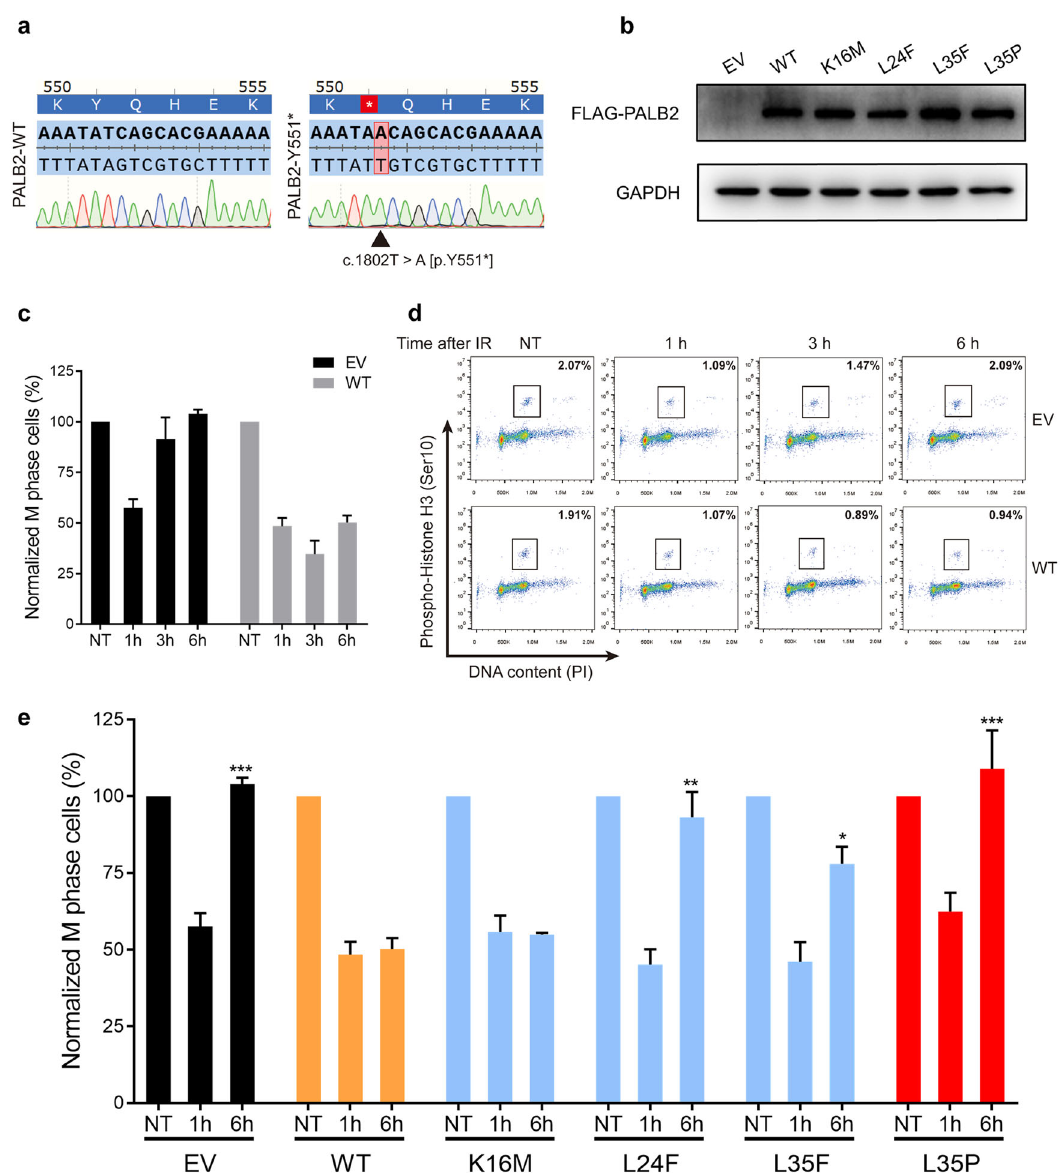
Fig. 3 Effects of PALB2 VUSs on G2/M checkpoint response. a Detection of the PALB2 nonsense variant (c.1802T > A, p.Y551*) of the EUFA1341 cell line. EUFA1341 cells express truncated PALB2 proteins lacking the ability to recruit BRCA2-RAD51. b Western blotting analysis of FLAG-tagged PALB2 expression in the EUFA1341 stable cell lines. c G2/M checkpoint response in EUFA1341 cells reconstituted with the empty vector (EV) or wild-type (WT) PALB2. Cells were treated with 3 Gy of IR and collected at indicated time points to measure the mitotic index by fl ow cytometry. Data represent the mean percentage (±SEM) of mitotic cells relative to the untreated cells (NT) from three independent experiments. d Representative fl ow cytometric plots of mitotic cells by phospho-histone H3 (Ser10) and propidium iodide (PI) staining. e G2/M checkpoint response in EUFA1341 cells stably expressing PALB2 constructs (or an empty vector, EV). Cells were analyzed before and at indicated time points after 3 Gy of IR. Data represent the mean percentage (±SEM) of mitotic cells relative to the untreated cells (NT) from three independent experiments. Statistical signi fi cance was analyzed by one-way ANOVA and Dunnett ’ s multiple comparisons test. The values of cells expressing indicated constructs were compared to cells expressing the WT PALB2 protein at the same time point. * P < 0.05; ** P < 0.01; *** P <